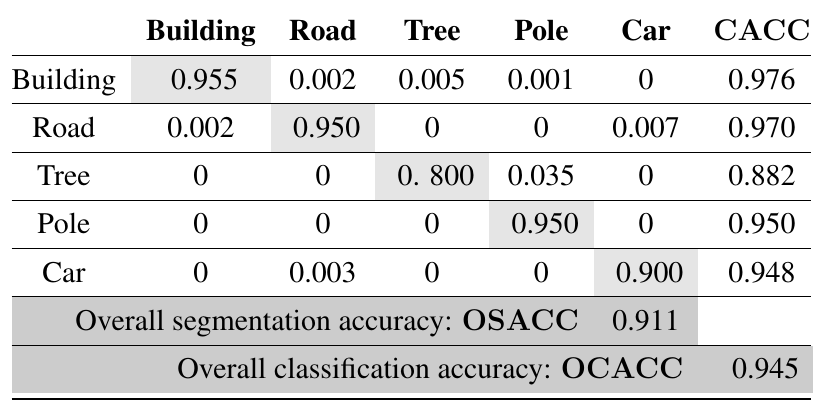
Table 7. Classification results of scene-C with the new evaluation